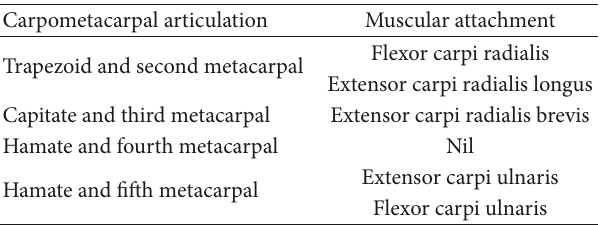
Table 1: Carpometacarpal articulations and muscular